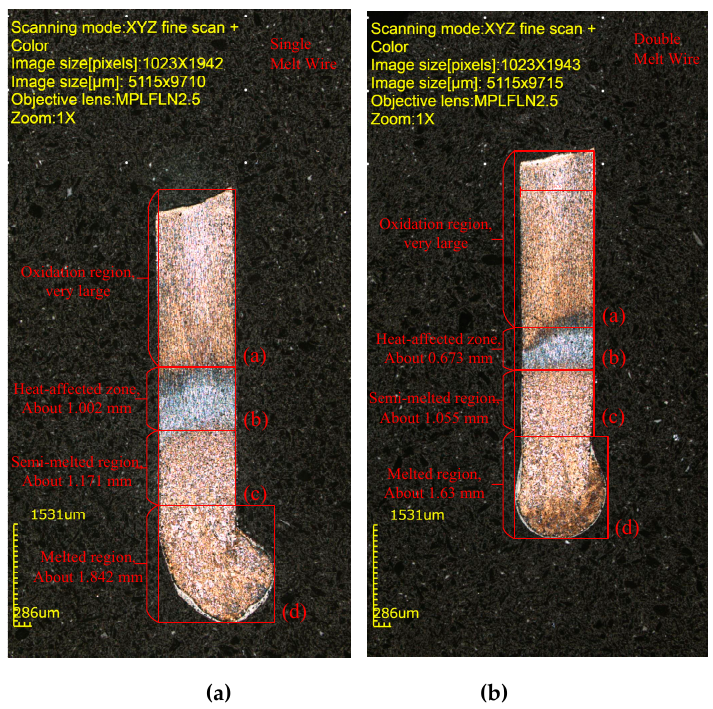
Figure 14. The laser scanning confocal microscope image of a melted wire. ( a ) Single metal wire and ( b ) double metal wire.